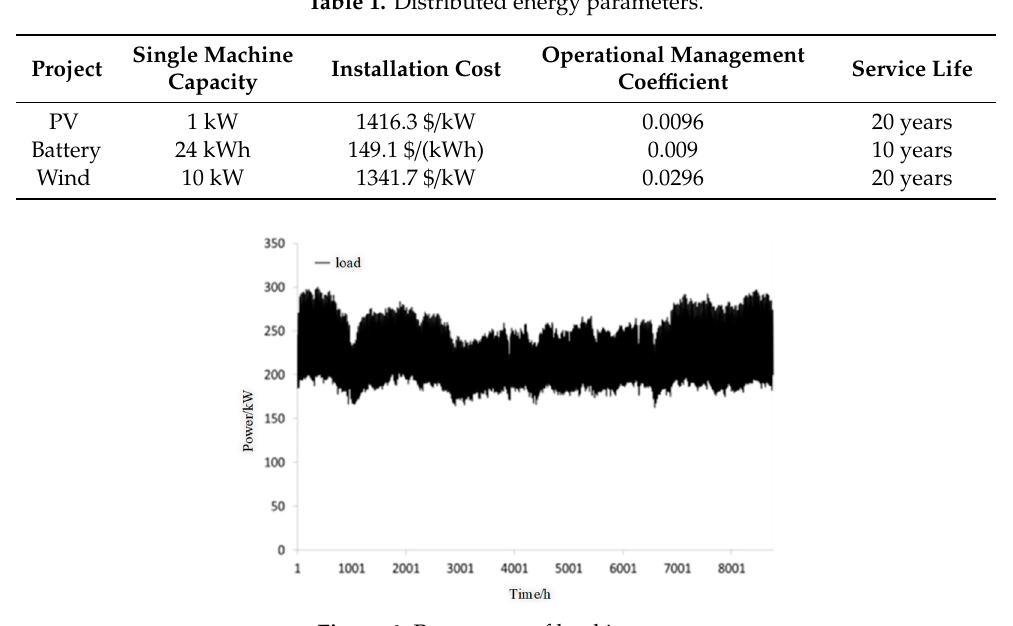
Figure 6. Parameters of load in a year.